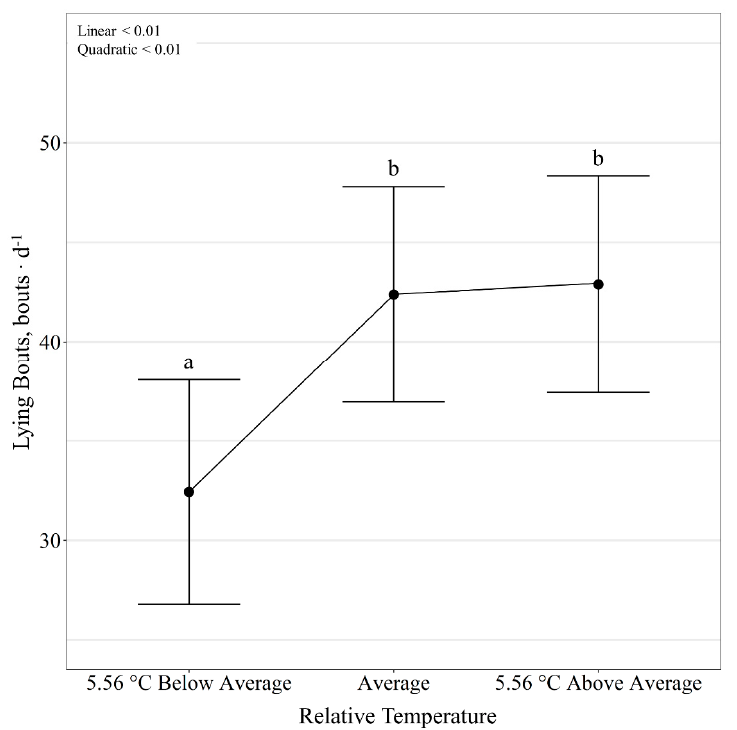
Figure 6. Influence of relative temperature change on lying time ( p < 0.01; expressed as bouts d − 1 ) by beef steers consuming either barley or corn-based feedlot diets at the Northern Agricultural Research Center, Havre, MT, USA. Data points without a common letter differ ( p < 0.05).